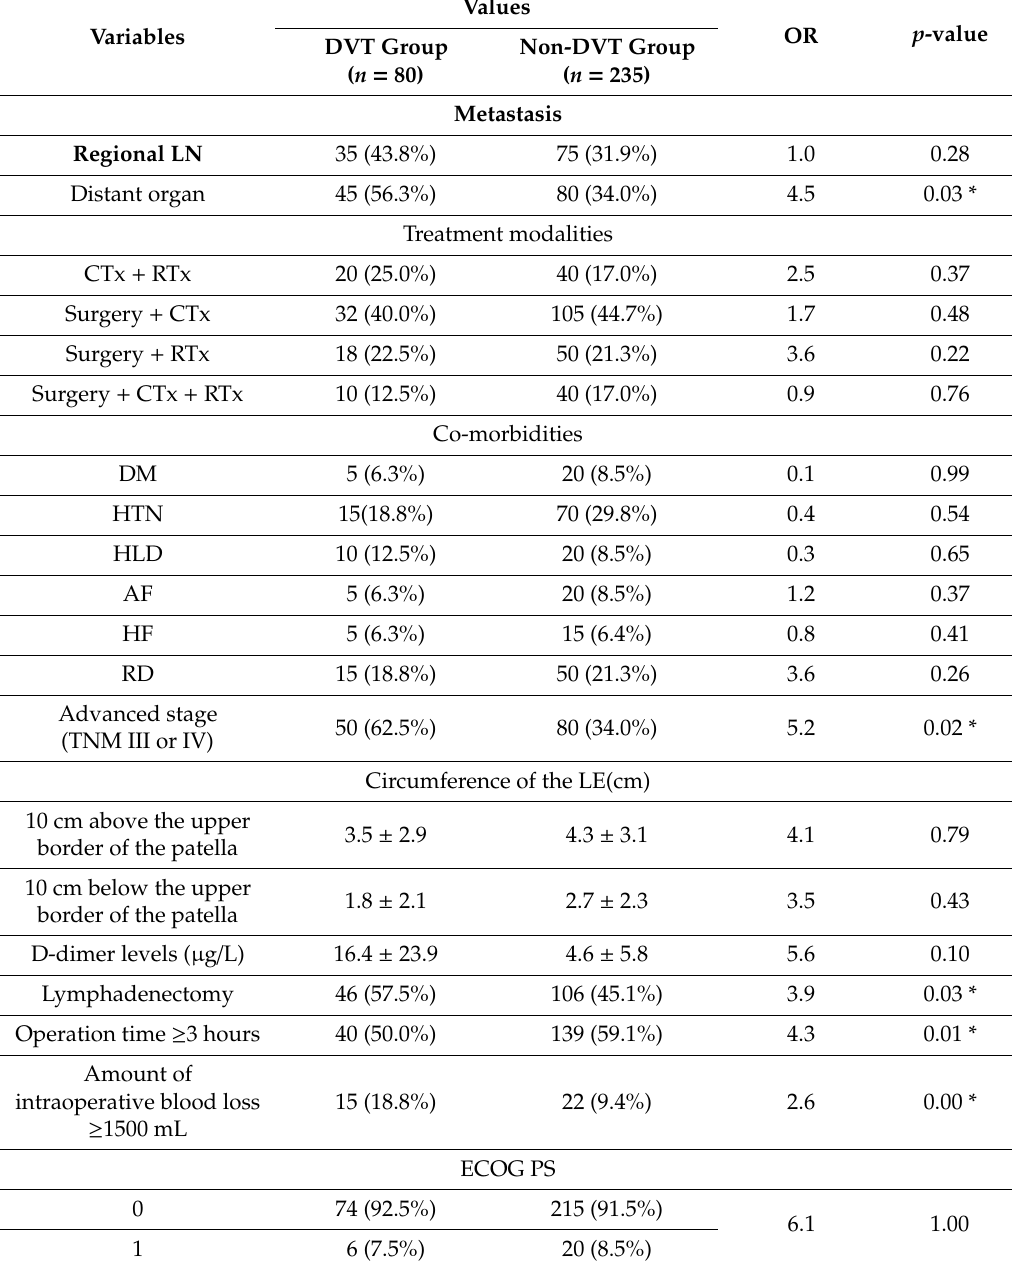
Table 3. Predictive factors of deep vein